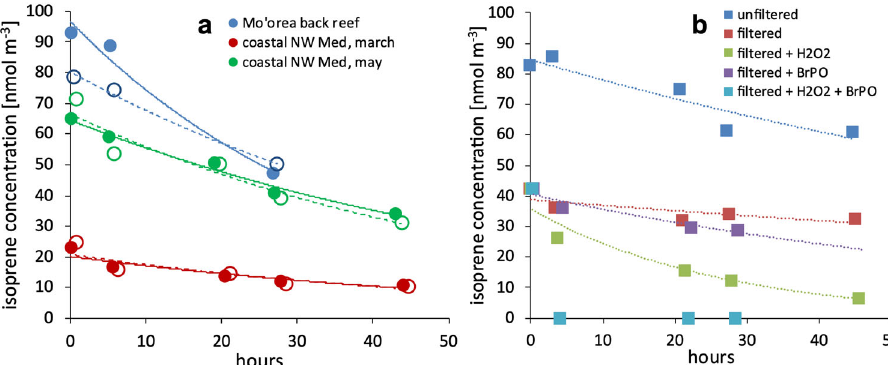
Fig. 1 Isoprene loss in dark incubations of coastal seawater. a Time course of isoprene concentration in 2 L dark incubations of non- fi ltered seawater samples from the back-reef lagoon of Mo ’ orea in April (blue) and the coastal Mediterranean in March (red) and May (green). Filled and open symbols correspond to duplicate incubations. Exponential fi ts to the data are shown by lines. See Supplementary Table 1 for fi t equations and metrics, water temperatures and chlorophyll a concentrations. b Time course of isoprene concentration in series of 30 mL dark incubations of coastal Mediterranean seawater. Dark blue: non- fi ltered; red: fi ltered through 0.2 µ m; green: fi ltered + 10 µ mol L − 1 H 2 O 2 ; purple: fi ltered + 0.0025 units mL − 1 bromoperoxidase (BrPO); light blue: fi ltered + H 2 O 2 + BrPO. Exponential fi t results in Supplementary Table